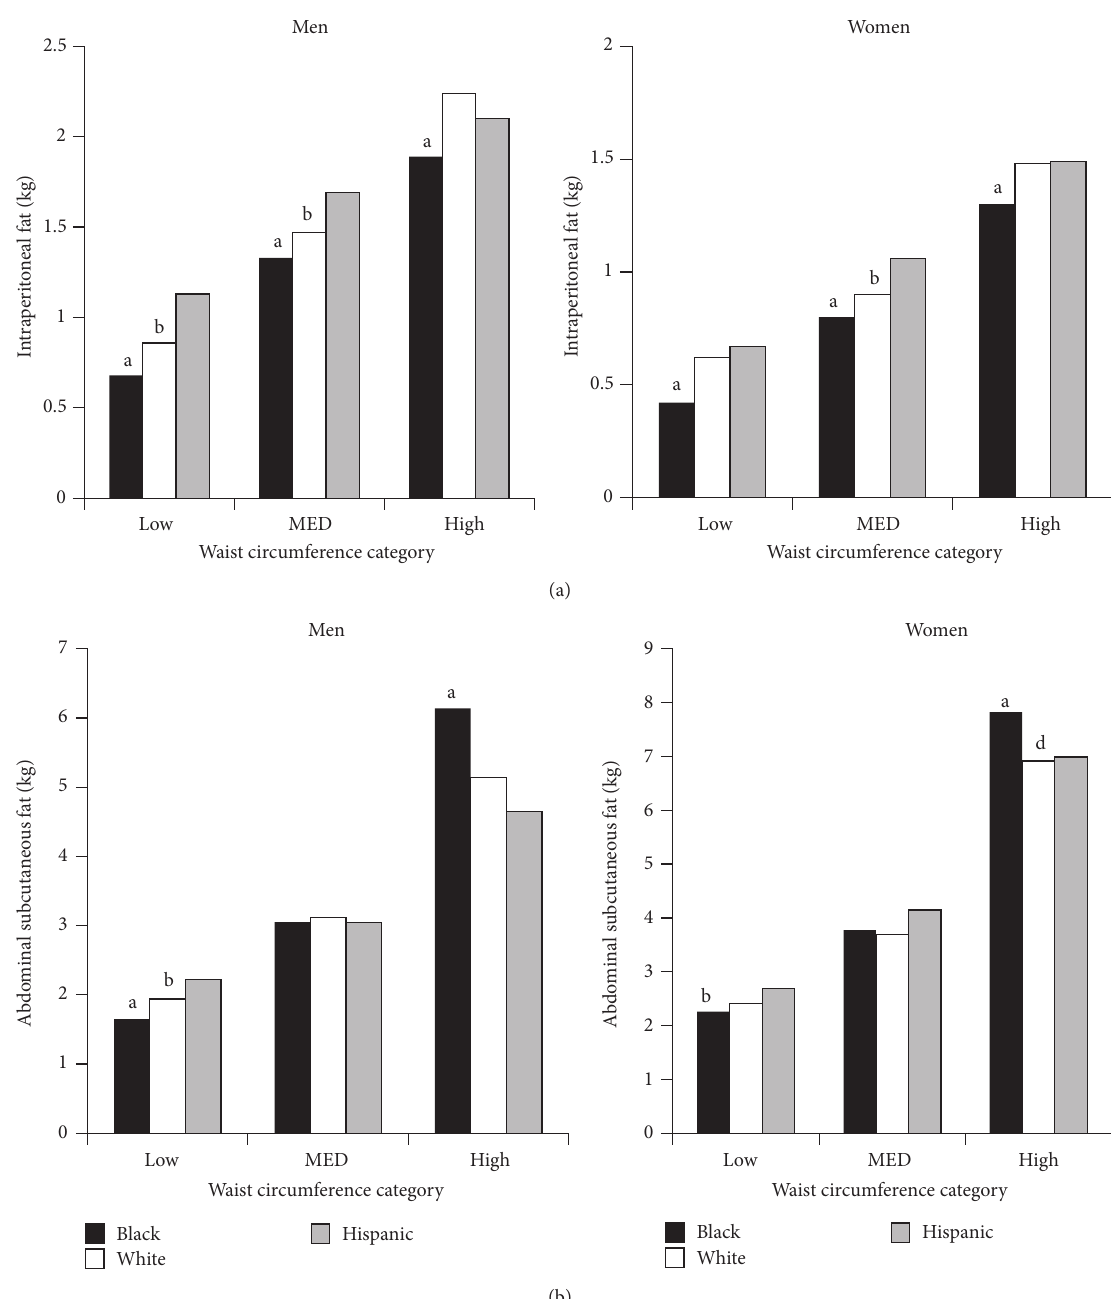
Figure 2: (a) Masses (kg) of intraperitoneal fat (IPF) for each waist circumference category for ethnicity and gender. Amounts of IPF increasedforlow,intermediate(MED),andhighwaistcircumferencecategories. a SignificantlydifferentfromwhitesandHispanics( 𝑃 < 0.02 ); b SignificantlydifferentfromHispanics( 𝑃 < 0.02 ).(b)Masses(kg)ofabdominalsubcutaneousfat(ASF)foreachwaistcircumferencecategory for ethnicity and gender. Amounts of ASF increased for low, intermediate (MED), and high waist circumference categories. a Significantly different from whites and Hispanics ( 𝑃 < 0.02 ); b significantly different from Hispanics ( 𝑃 < 0.02 ).